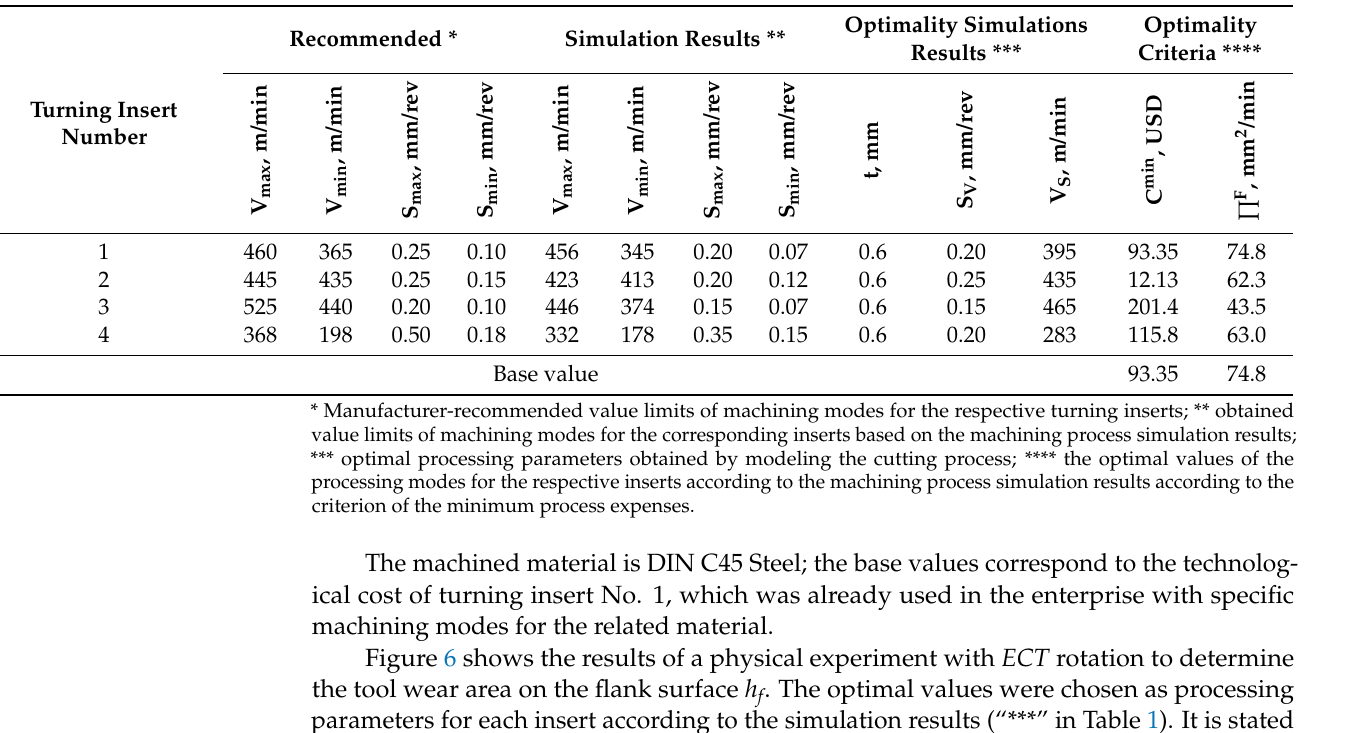
Table 1. Results of the ECT quality assessing and machining modes